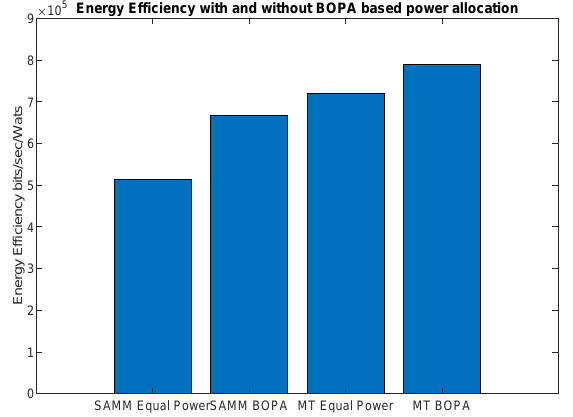
Figure 6. The system energy efficiency with and without BOPA based power